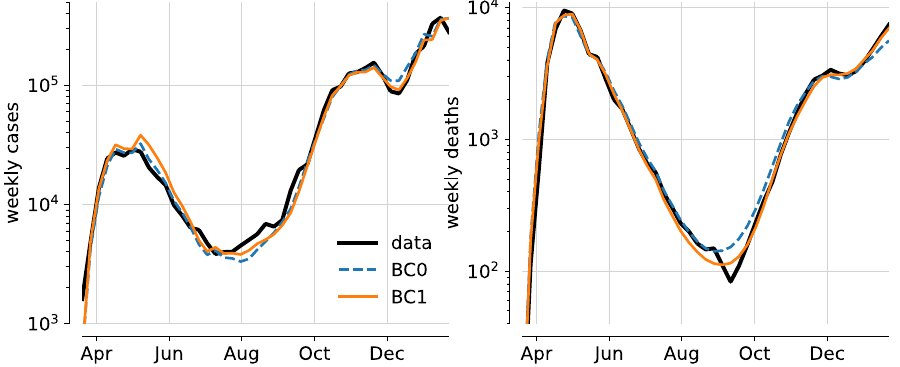
Fig 3. Mean trajectories of weekly cases and deaths for model variants BC0 and BC1. Deterministic trajectories for the MAP parameters of models BC0 (dashed blue) and BC1 (solid orange), along with data (black).